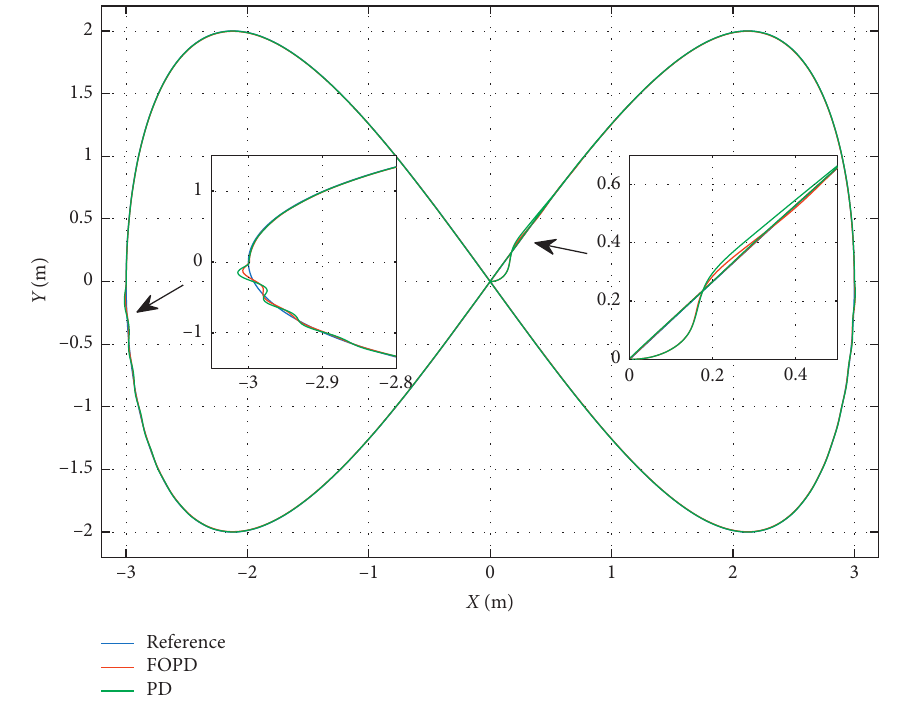
Figure 9: Trajectory tracking performance comparison.